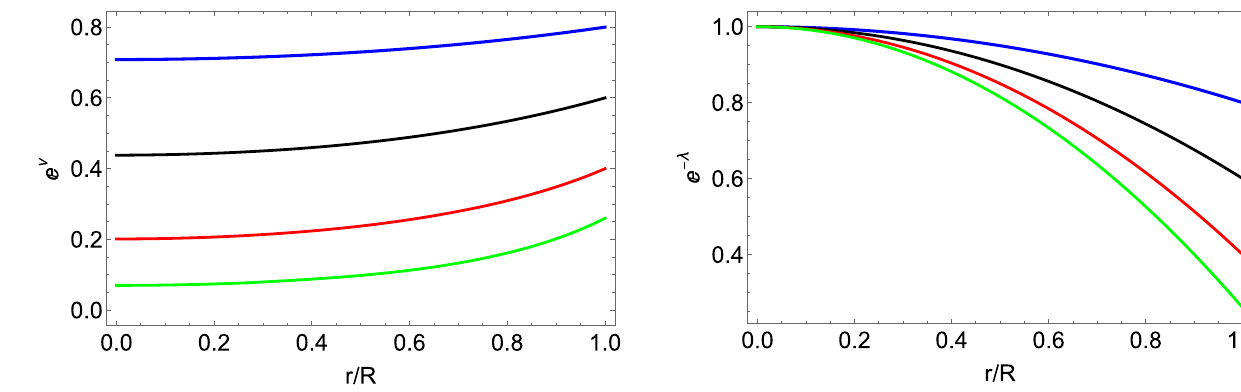
Fig. 2 e − λ for u = 0 . 1 (blue line), u = 0 . 2 (black line), u = 0 . 3 (red line), u = 0 . 37 (green line) and (cid:13) = 1